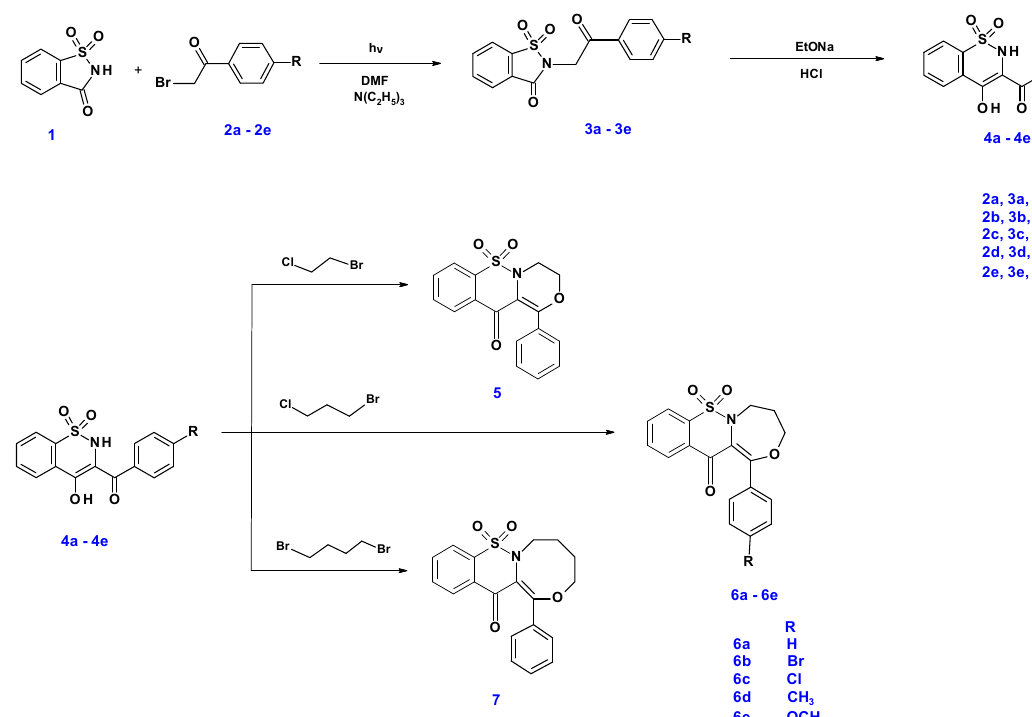
Scheme 1. The synthetic route of new tricyclic 1,2-thiazine derivatives.